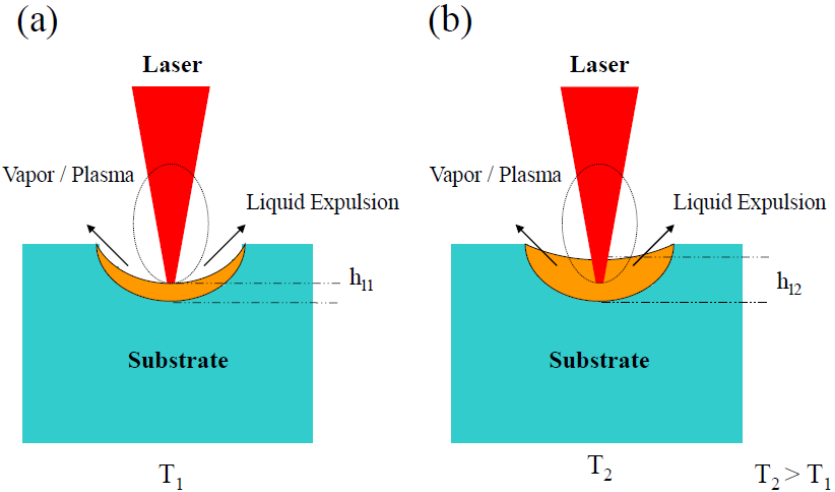
Figure 1. Scheme of ablation process and molten layer of thickness h interaction zone at room temperature T increases when the surface temperature of the glass-ceramic substrate is